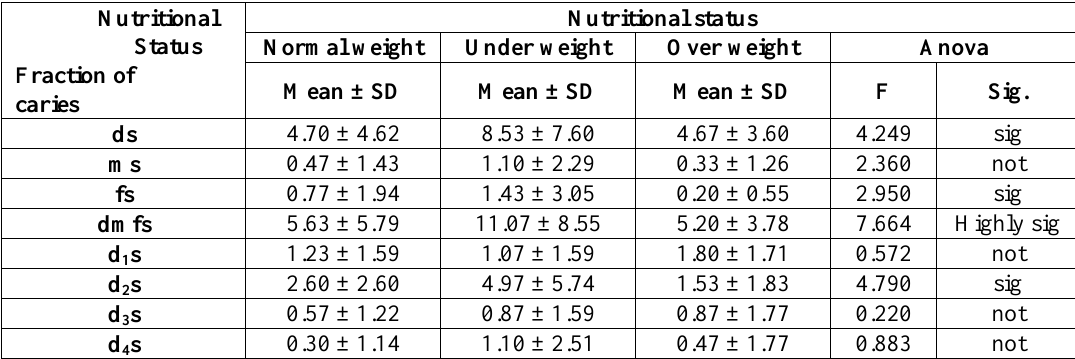
Significance level at P <0.05 Highly significance level at P